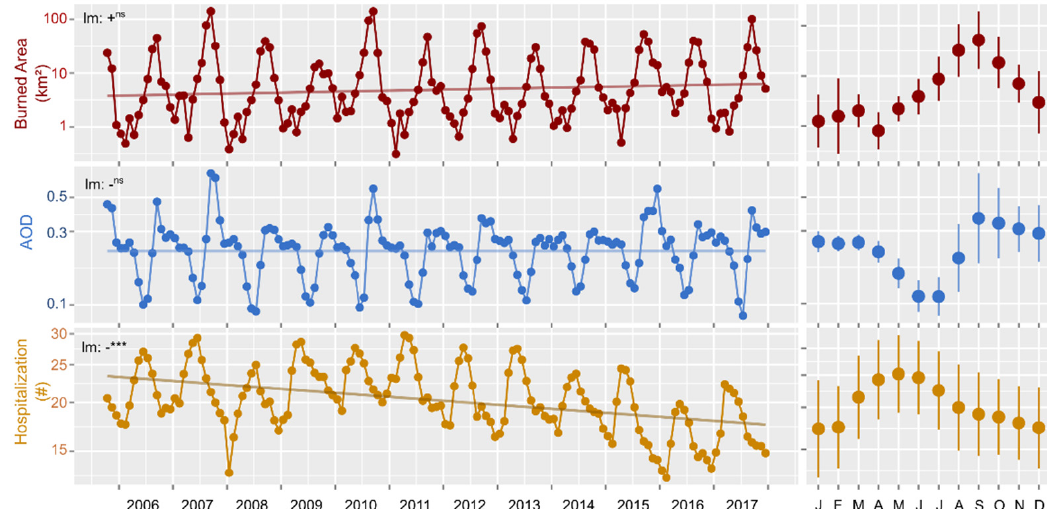
Figure 3. Temporal variation in monthly average values for burned area, AOD, and total hospitalizations. The indicative of the linear trend (lm) is indicated in the up-left corner for each plot, where ns is not significant and *** is for p < 0.001.